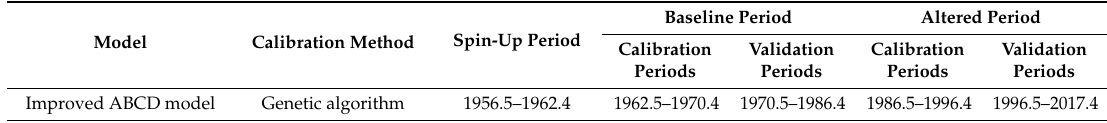
Table 4. Calibration and validation period